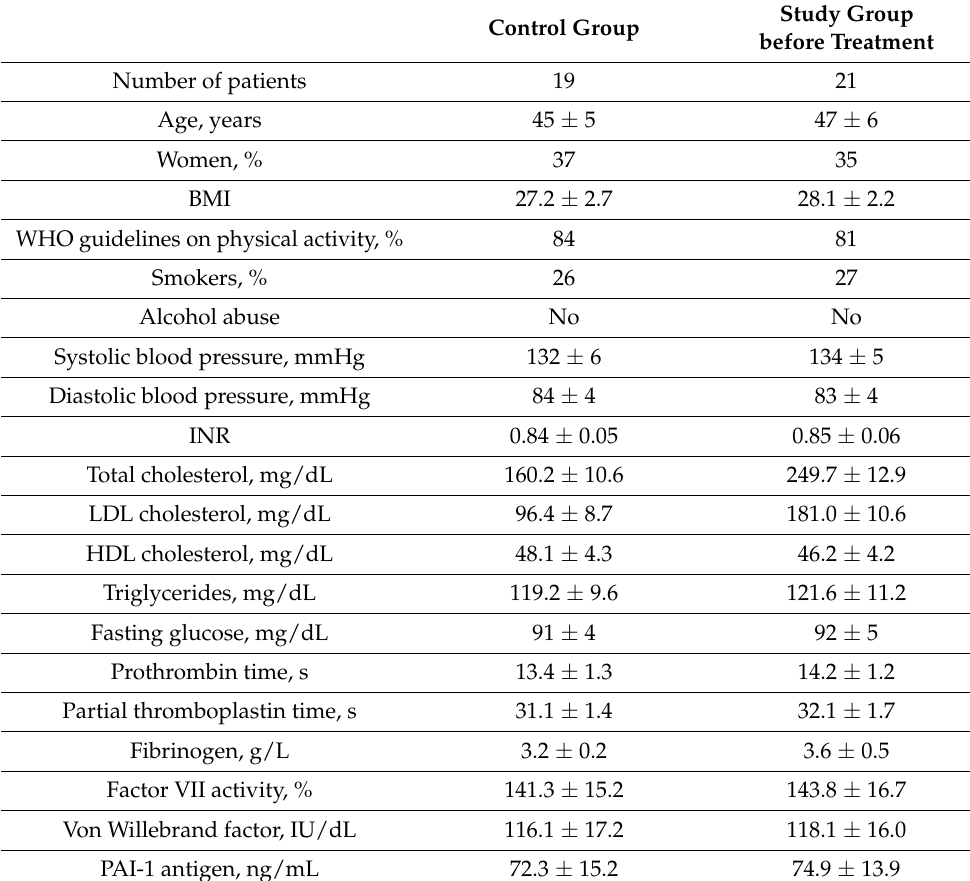
Table 1. Baseline characteristics of patients (values are mean ± SD unless indicated